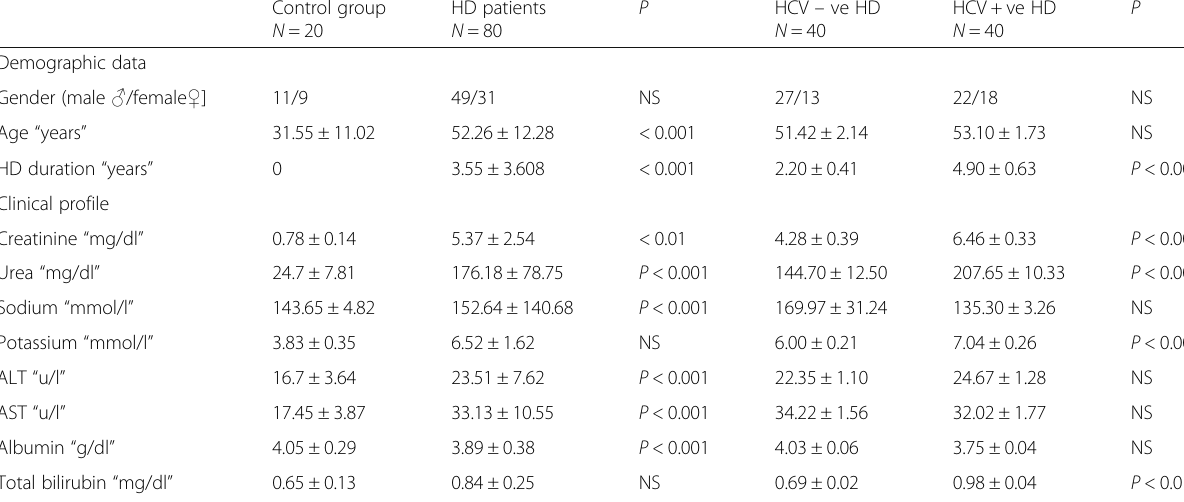
Table 1 Demographic and laboratory characteristics of the investigated groups Control group N =